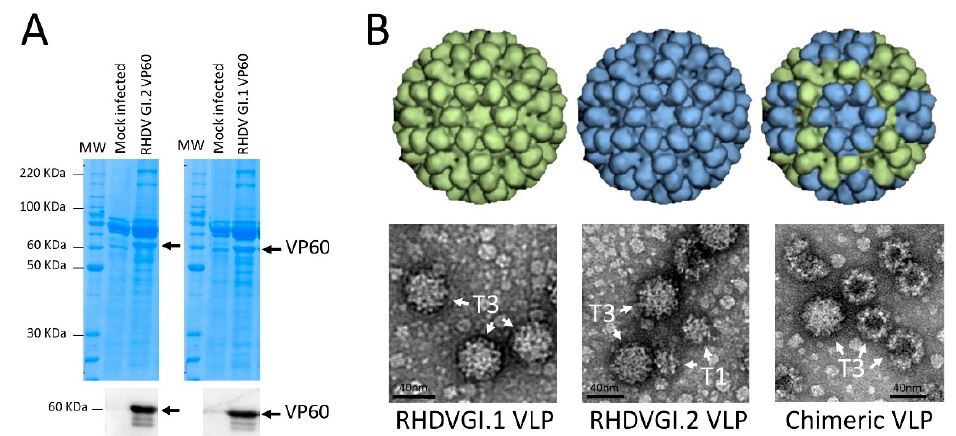
Figure 1. Expression of protein VP60 from RHDV GI.1 (isolate AST89) and RHDV GI.2 (isolate N11) in T. ni pupae by two different recombinant baculoviruses, and VLP formation by infecting the pupae with individual baculovirus or co-infecting with both vectors. ( A ) SDS-PAGE gels resolving the extracts from infected pupae with individual baculovirus and stained by Coomassie blue. VP60 protein is indicated with an arrow. VP60 proteins were also detected by Western blot using the monoclonal antibody 1A2 recognising the VP60 from both serotypes. The full uncropped blot is included as supplemental Figure S1. ( B ) A 3-D model of the hypothetic conformation of the resulting VLP after infection with individual recombinant baculovirus and the resulting VLPs after co-infecting with both vectors. Representative electron micrographs of purified VLPs resulting from the infection with individual baculovirus or after a co-infection (chimeric). T3 and T1 structures observed are indicated in the images with arrows.